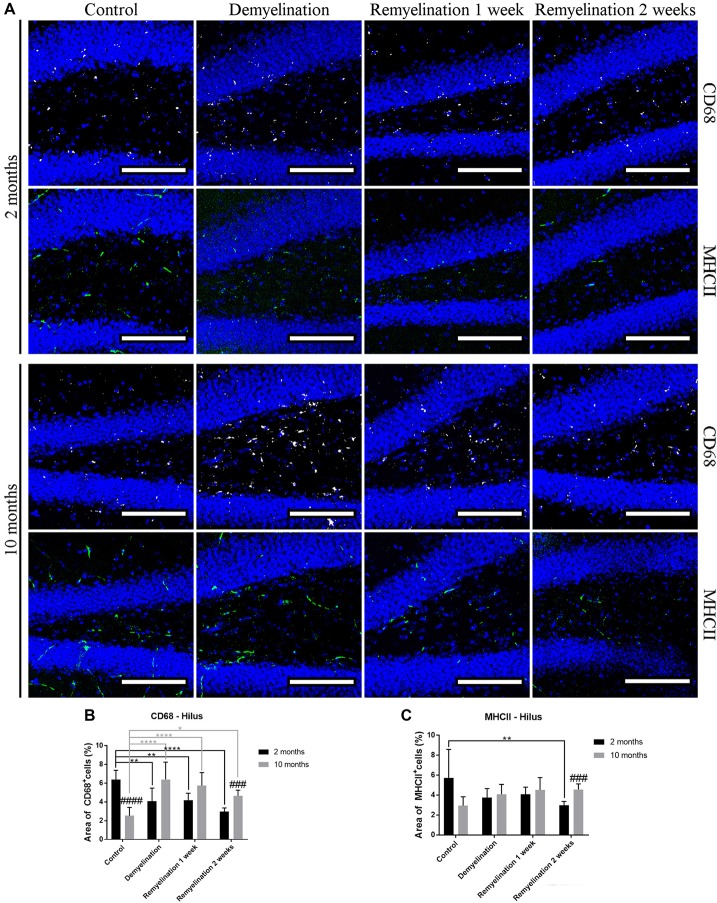
Age-related heterogeneity in CD68 and major histocompatibility complex II (MHCII) in the hilus of the hippocampal DG. (A) CD68 (white) and MHCII (green) labeling. Cell nuclei are stained with DAPI (blue). (B) There was an age-related difference of CD68 staining in the control groups (higher in the younger controls). In the young groups, the percentage of CD68 staining decreased significantly during de- and remyelination, whereas the opposite was observed for the middle-aged groups. These different patterns led to a significantly higher CD68 level in the middle-aged group in comparison to the younger one after 2 weeks of remyelination. (C) MHCII expression was significantly reduced in the younger group after 2 weeks of remyelination. At the same time point, there was a significant age-related difference, with higher levels of MHCII in the middle-aged group. Values are shown as means + SD (n = 6 per group). Statistical significance was evaluated using a two-way ANOVA and a Tukey’s post hoc test. The p-values are indicated in the graphs: treatment effects within the same age group: *p < 0.05, **p < 0.01 and ****p < 0.0001, age-related differences: ###p < 0.001 and ####p < 0.0001. Bars: (A) 100 μm.